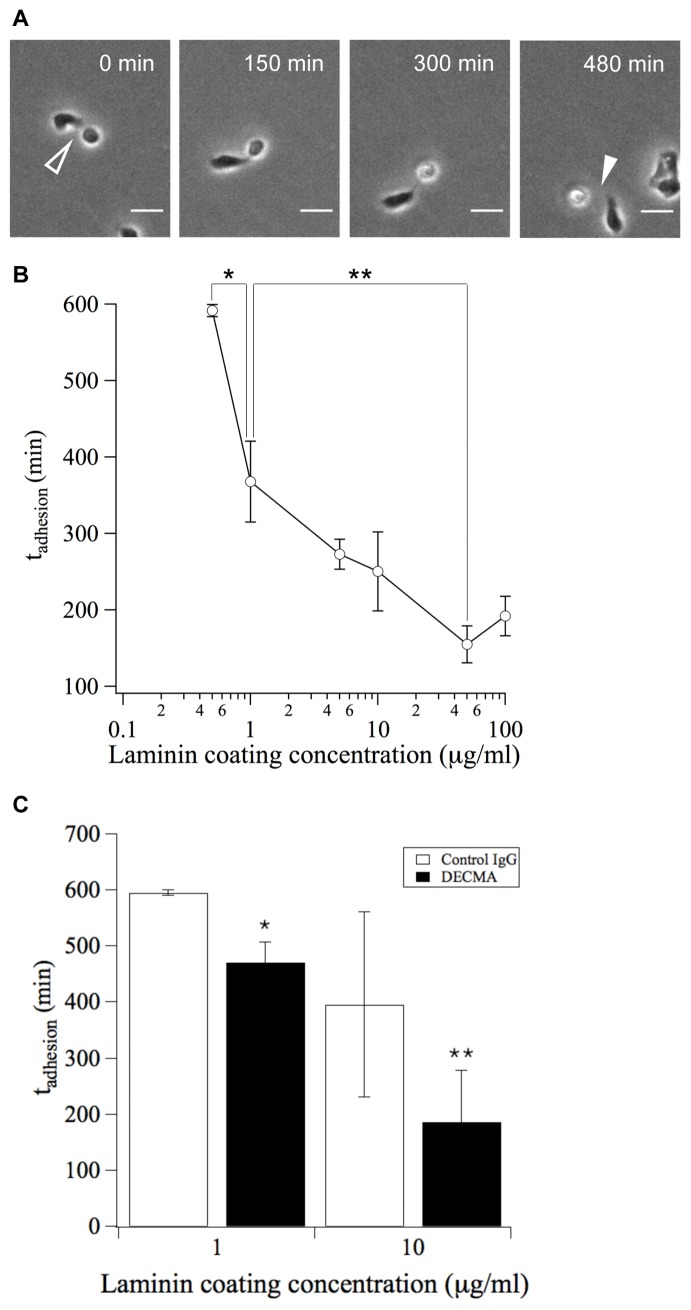
The timescale of local cell-cell reactivity (tadhesion) is dependent on substratum adhesivity.(A) Timelapse phase contrast images of migrating MDCK cells show the initiation of cell-cell contact (open arrowhead) and the subsequent detachment (closed arrowhead). Because ton and toff cannot be distinguished experimentally, timelapse images were used to quantify the total duration of cell-cell interactions (tadhesion) as a lumped measure of ton and toff. Scale bar, 25 µm. (B) The duration of cell-cell interactions (tadhesion) was quantified for substrata prepared with different coating concentrations of Ln. Error bars, s.e.m. (n = 2–3 trials; N>50 cell pairs per trial). *P<0.06 between 0.5 µg/mL and 1 µg/mL conditions. **P<0.07 between 1 µg/mL and 50 µg/mL conditions. (C) The duration of cell-cell adhesions (tadhesion) was measured in the presence of an E-cadherin-specific or non-specific control IgG. Error bars, s.e.m. (n = 2 trials; N = 30–80 cell pairs per trial). *P<0.05 between DECMA and Control IgG conditions for 1 µg/mL Ln coating concentration. **P<0.2 between DECMA and Control IgG conditions for 10 µg/mL Ln coating concentration.